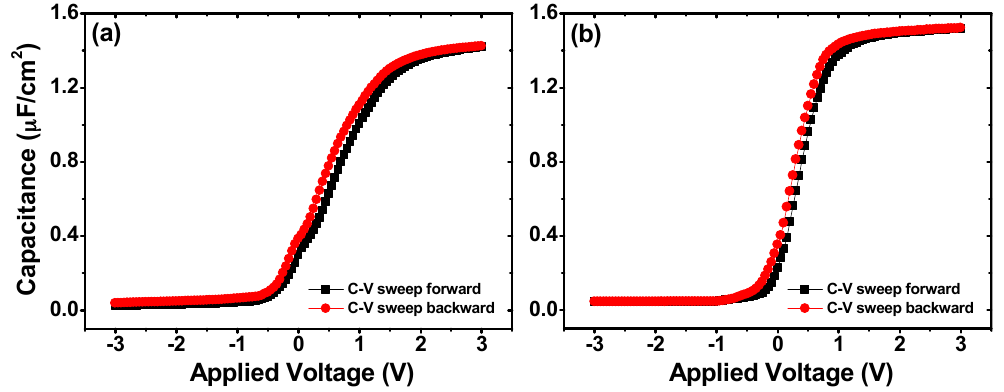
Figure 6. C - V characteristics of MIS capacitors using 5 nm ( a ) O 3 -based and ( b ) H 2 O-based La x Al y O films as insulators.